Question: What visual encoding does this figure use to show its data?
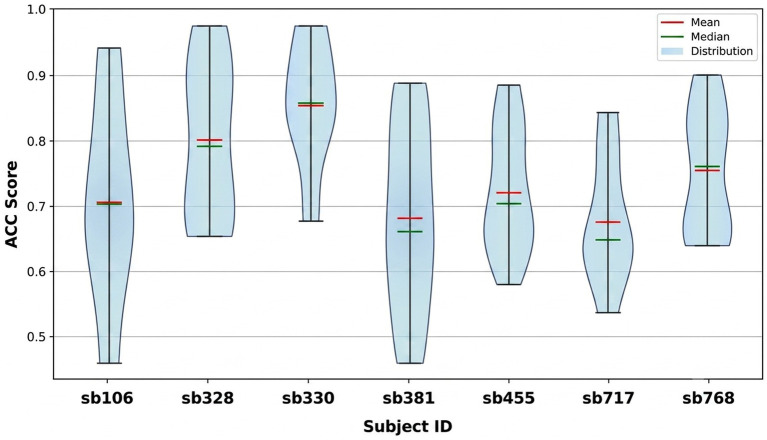
Answer: box